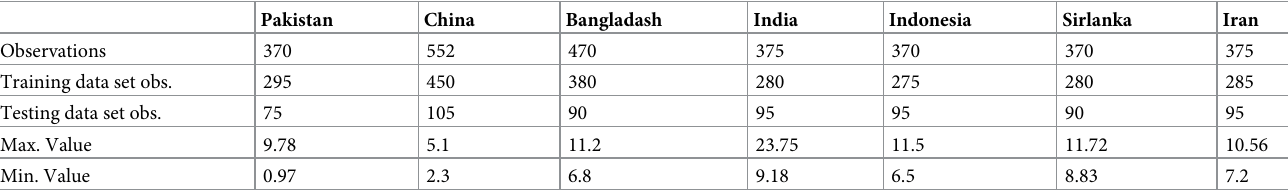
Table 1. Description of Asian developing countries unemployment data